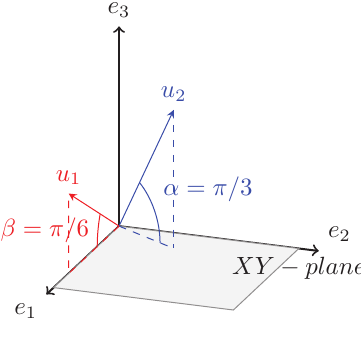
Figure 1. The signal subspace is defined by vectors e 1 and e 2